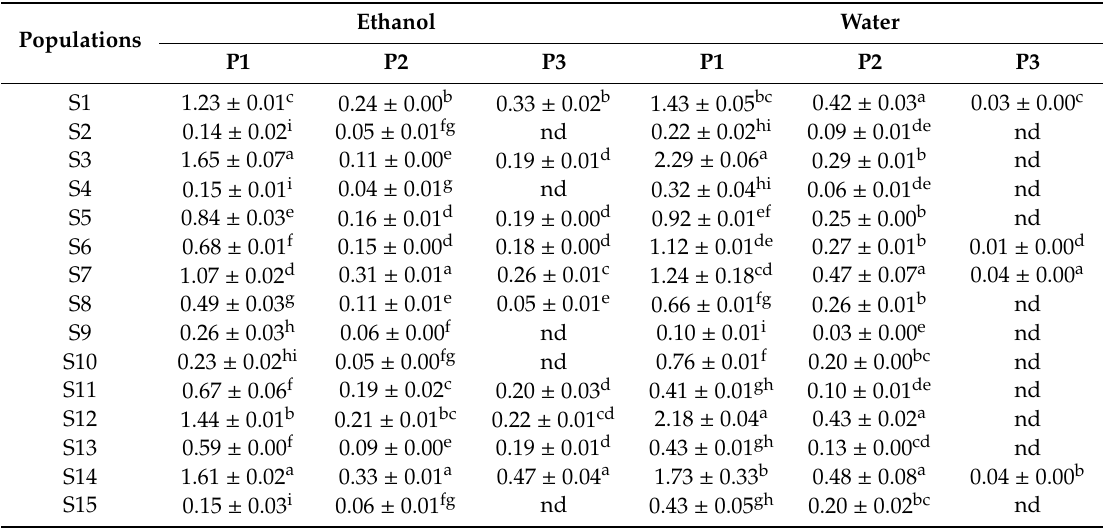
Table 1. The content (mg / g) of phenolic acid in ethanol and water extracts of C. paliurus leaves.